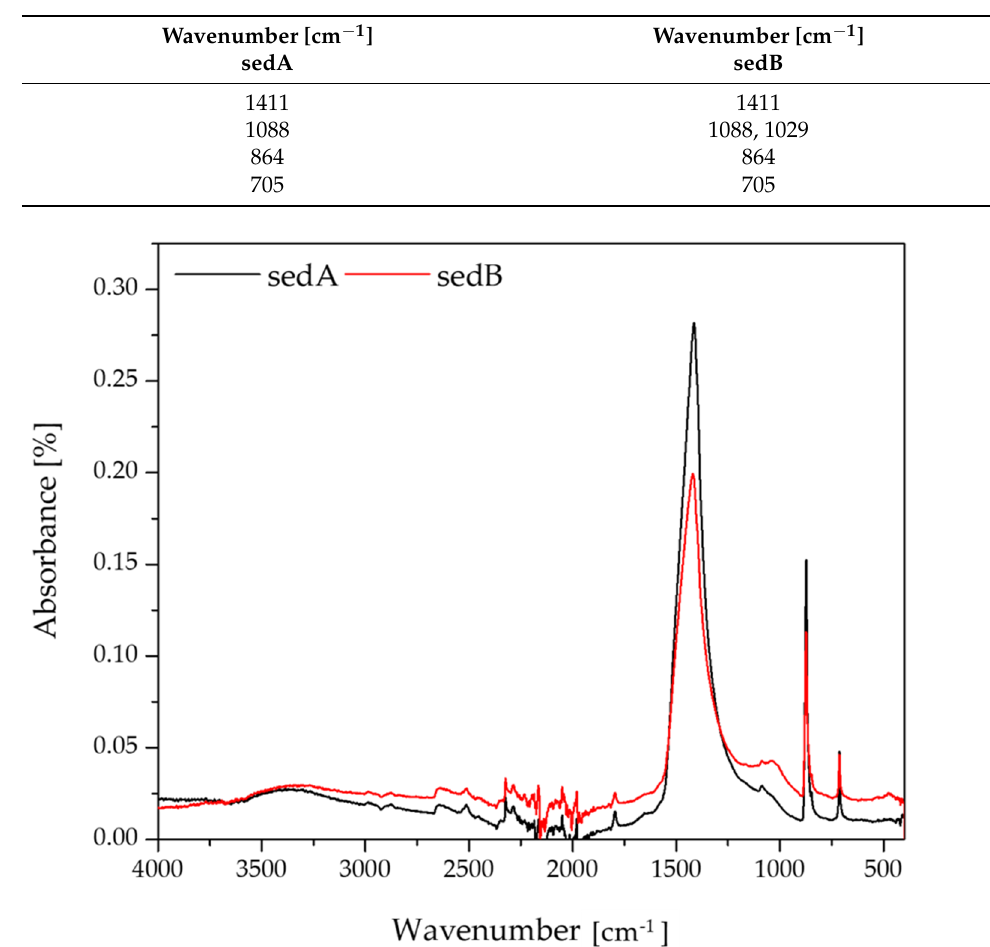
Figure 2. FT-IR spectra of sediments.